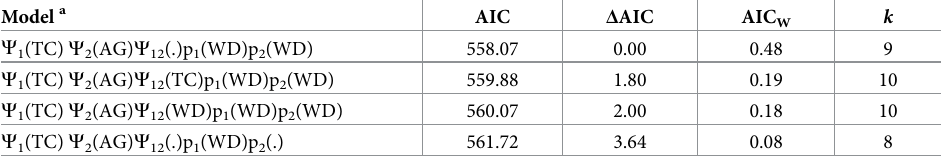
Table 2. Model selection results showing models with a cumulative AIC weight of 0.95. C represents the probabil- ity of habitat use (occupancy parameter), p represents the detection parameter. Species codes are as follow: 1 = northern tiger cat; 2 = jaguarundi; 12 = both. k indicates the number of parameters for each model.